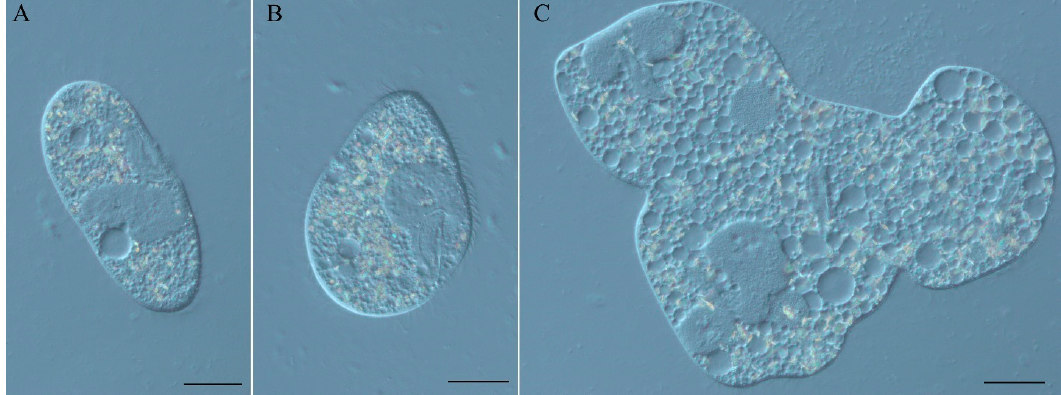
Figure 1. ( A ) P. tetraurelia strain 51 wild type cell; ( B ) Spinning Top mutant cell; ( C ) Spinning Top multinuclear monster cell. DIC, Nikon Eclipse Ni-U microscope (Nikon, Japan). Scale bar is 20 µm.